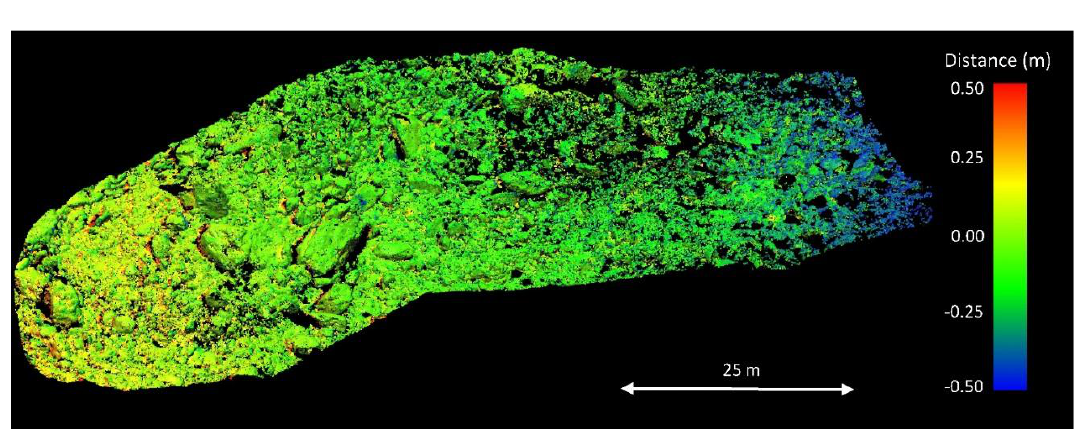
Figure 7. Three dimensional view of the spatial distribution of the Multiscale Model-to-Model (M3C2) distances between the benchmark Terrestrial Laser Scanner (TLS) 3D model and the point cloud produced by Agisoft Photoscan with Low Dynamic Range (LDR) images for the year